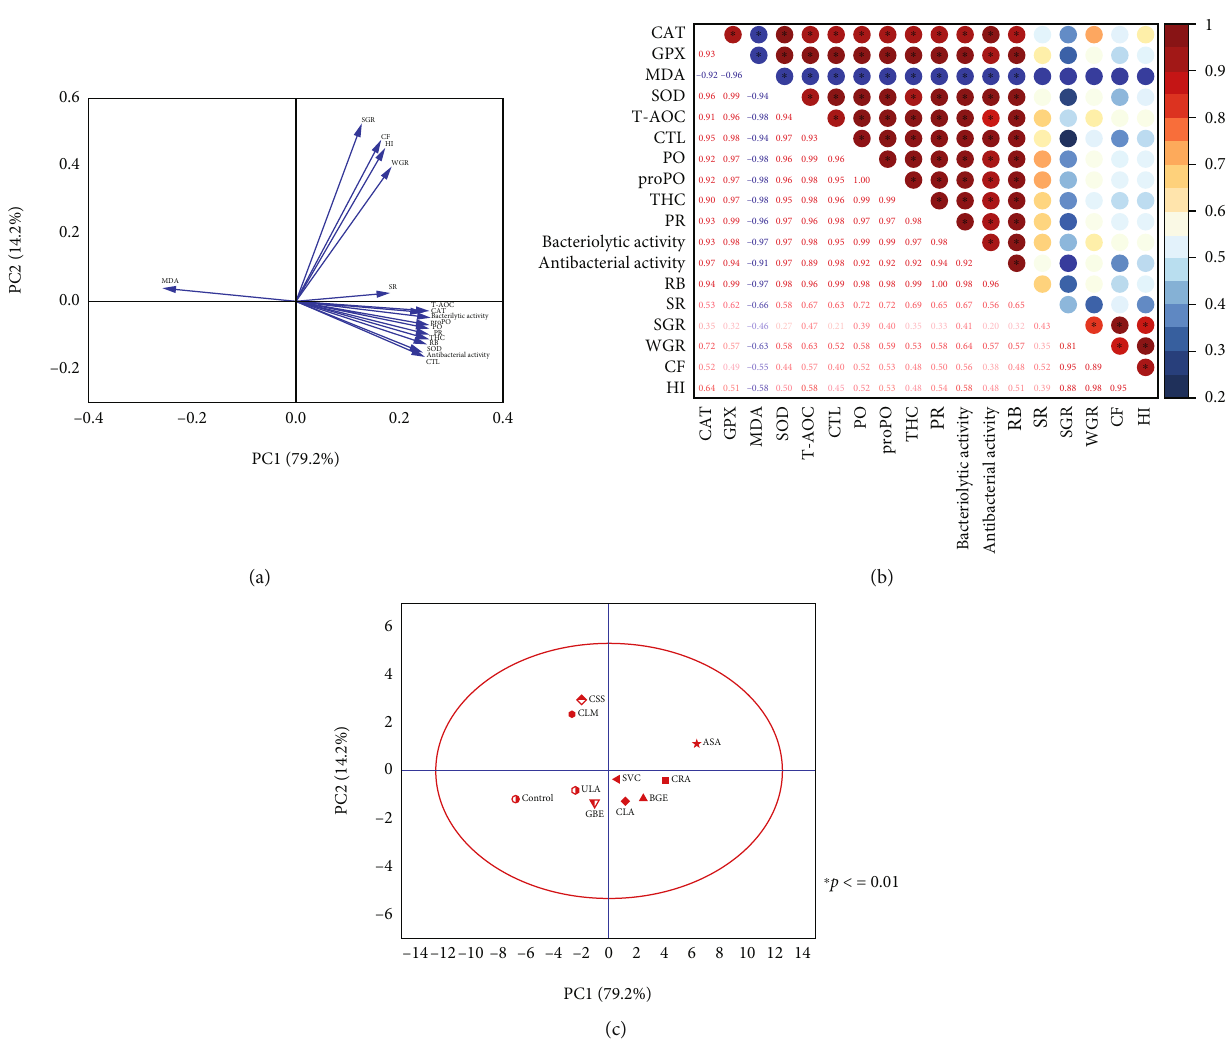
Figure 5: The principal component analysis and signi fi cant correlation between all indicators in the macroalgae and control groups. The principal component analysis and graph of correlation on the loading plot (a), graph of correlation (b), and score plot (c) of L. vannamei in di ff erent groups. Positive correlations are shown in red; absence of correlation in white; and low correlations in